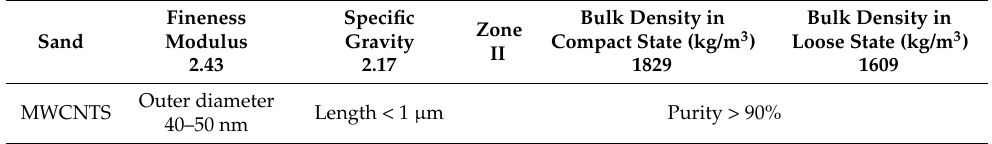
Table 2. Physical properties of sand and MWCNTs.